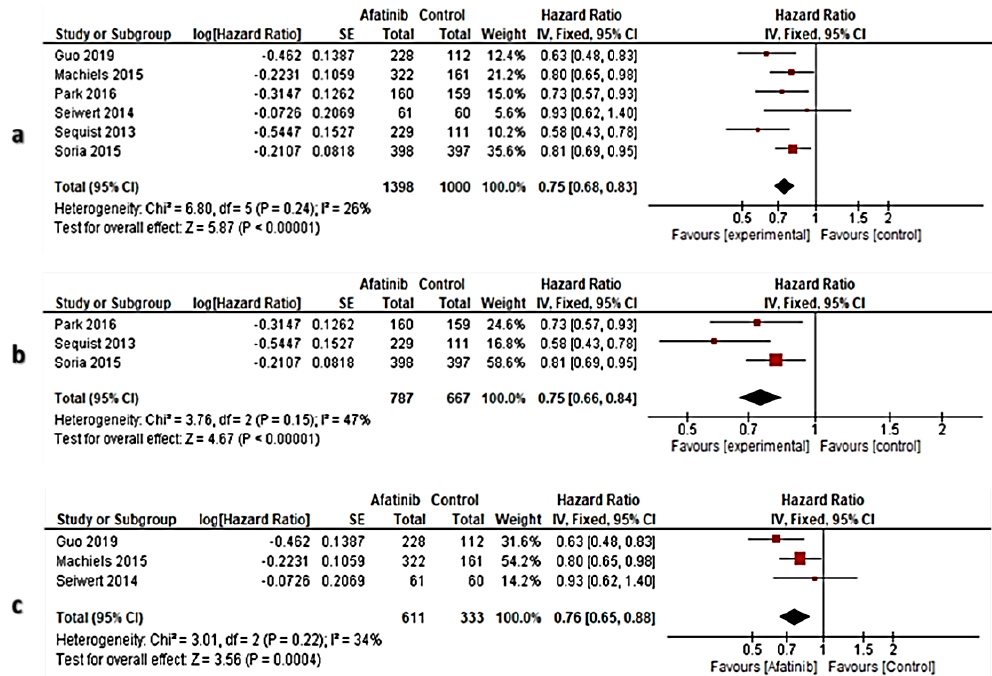
Figure 5. Forest plot of PFS; ( a ): Subset of PFS in all RCTs, ( b ): The subset of PFS in NSCLC, ( c ): The subset of PFS in HNSCC. Fixed effect model of meta-analysis has proceeded. Red color is the CenterPoint of the confidence interval expressing the weight of the sample size in each RCT, while black-colored diamond denoted the overall effect